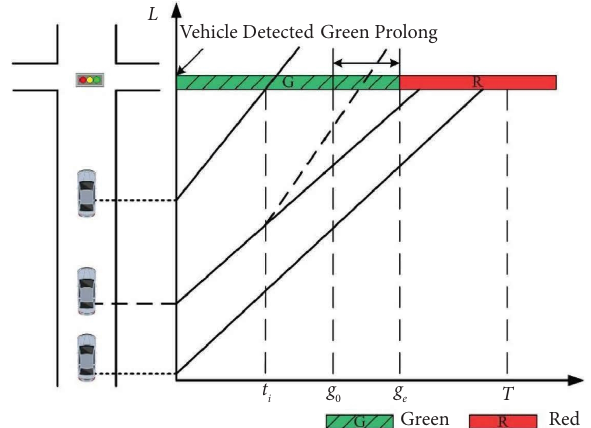
Figure 4: Te schematic diagram of the trajectory of vehicles in the speed control